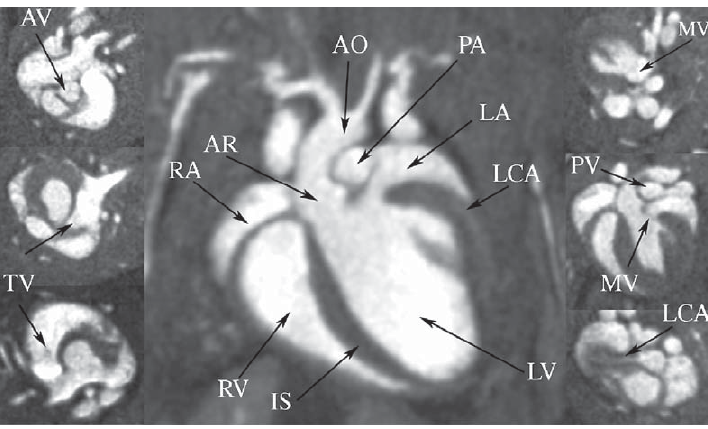
Fig. 16. MRM imaging at resolution of 87 (cid:1) m allows clear visualization of the four major compartments of the mouse heart: left (LV) and right ventricles (RV), left (LA) and right atria (RA), as well as the intraventricular septum (IS). The major cardiac blood vessels are visible: the left carotid (LCA) feeding the heart, the aorta (AO) ands its root (AR), as well as the pulmonary arteries (PA). In addition, the valves for the aorta (AV) and pulmonary artery (PV), as well as the tricuspid (TV) and mitral valve (MV), are identifiable (insets). Reproduced with permission from [12].